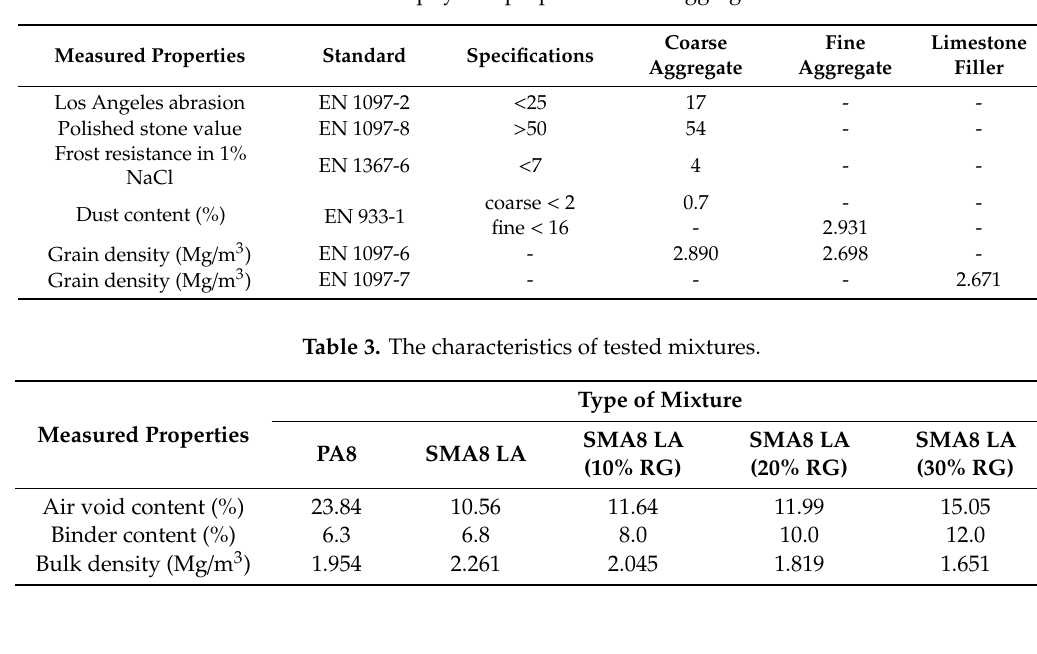
Table 2. The physical properties of the aggregate.